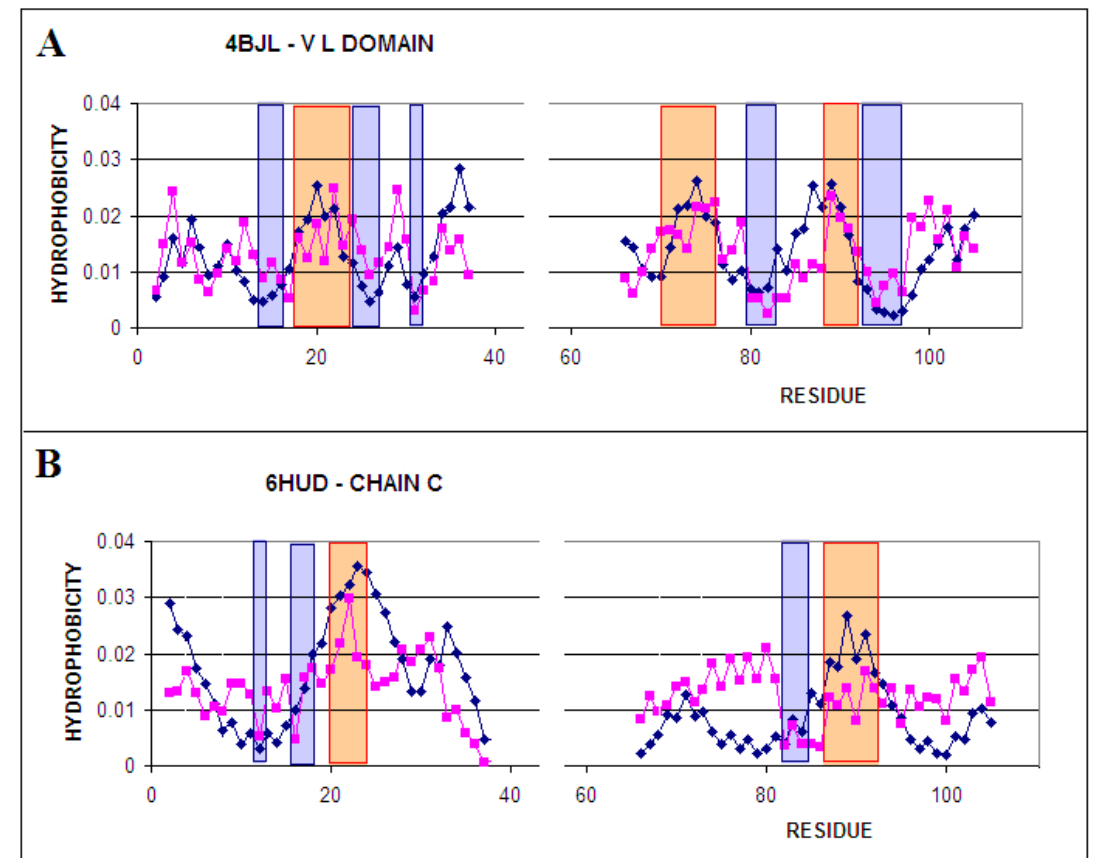
Figure 5. T and O hydrophobicity distribution for: ( A ) Light chain V domains; ( B ) in amyloid form; only segments 2–33 and 66–105 are taken under consideration